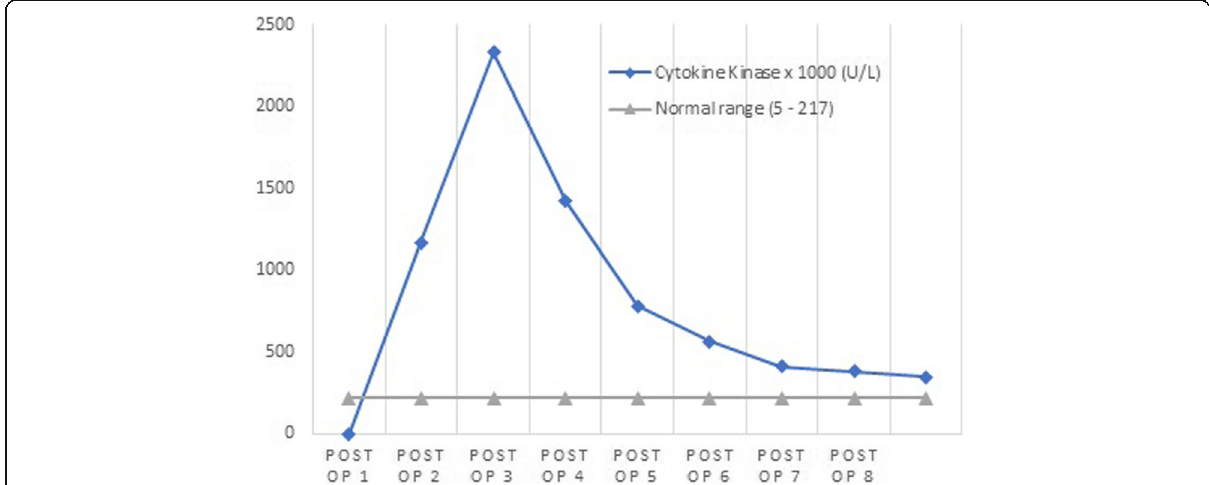
Fig. 1 The changing levels of serum creatinine kinase (U/L) after the operation. CK value sharply increased 2days after operation followed by a dramatic escalation on the third day postoperation. However, as swift and timely diagnosis and treatment was performed, 5days after the operation, the value of CK dropped to normal range. CK value on the figure displayed as 1000 times. Abbreviations: CK, creatinine kinase, Post-op, postoperative